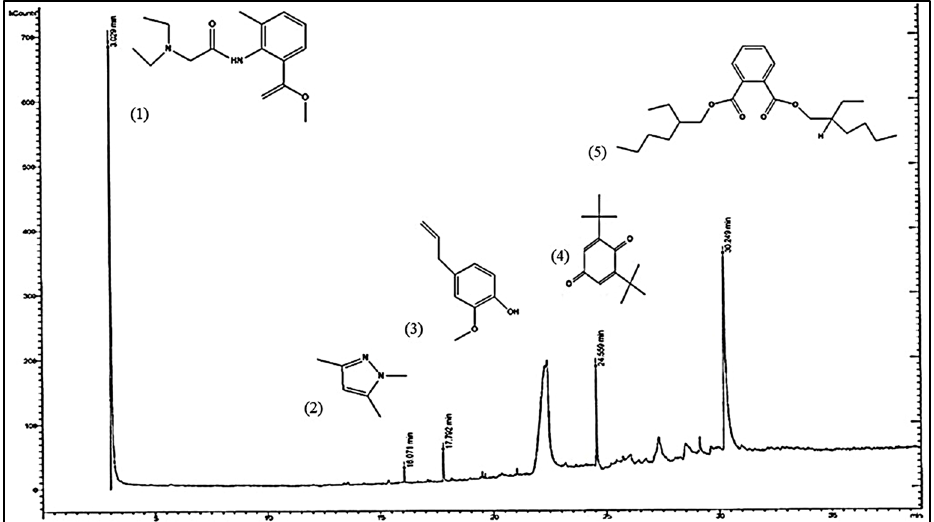
Figure 6. GC-MS chromatogram of EtOAc extract of P. neglecta. Chemical structures of bioactive compounds identified as: (1) tolycaine; (2) 1H-pyrazol, 1,3,5-trimethyl-; (3) eugenol; (4) 2,5-cyclo-